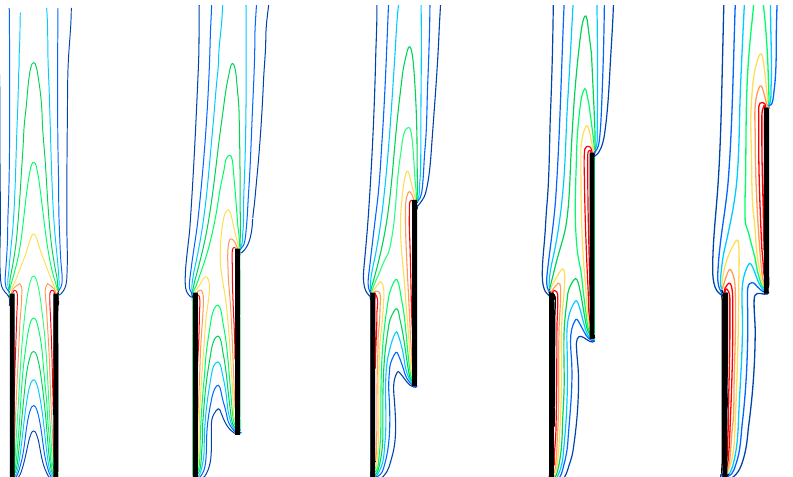
Figure 3. Isotherm contour plots for Ra H = 10 5 , W / H = 0.25 and L / H = 1, 0.75, 0.5, 0.25, 0 using a scale from blue ( T = 0 ) to red ( T = 1 ) .